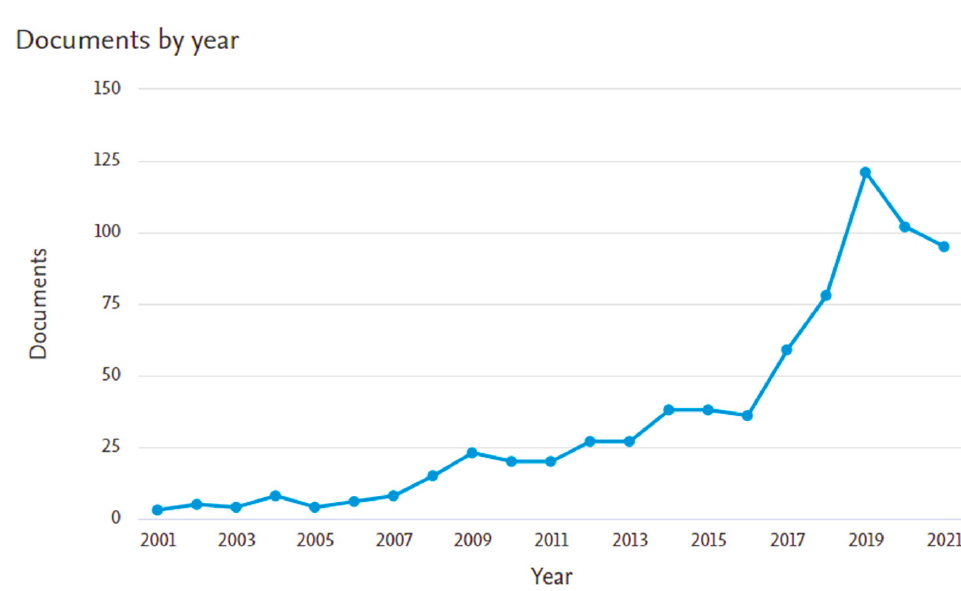
Figure 3. Annual publication pattern.